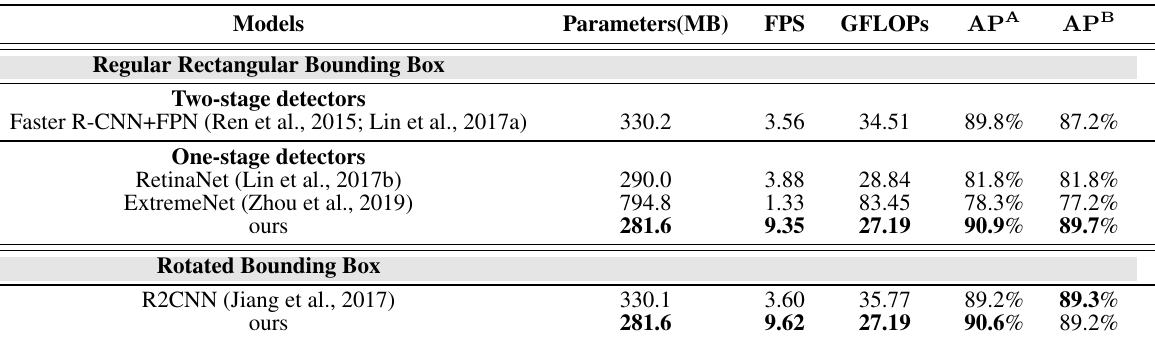
Table 1. Numerical ship detection results on Dataset A and Dataset B. We derive the ship instances both in the forms of the regular rectangular bounding boxes and the rotated bounding boxes from the extracted keypoints with our method. We compare our method with some other methods in Average Precision (AP). FPS is short for Frames Per Second and the results are tested on a NVIDIA